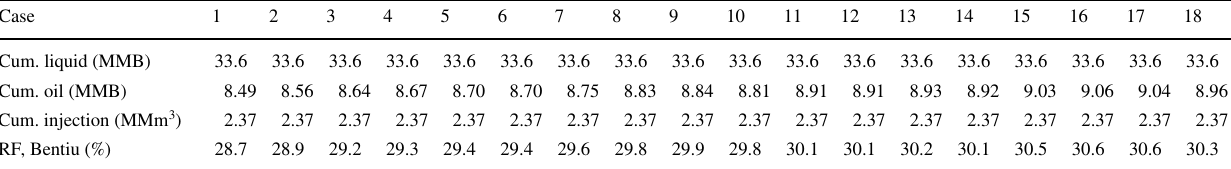
Table 11 Forecast result of steam quality and steam temperature optimization cases Case